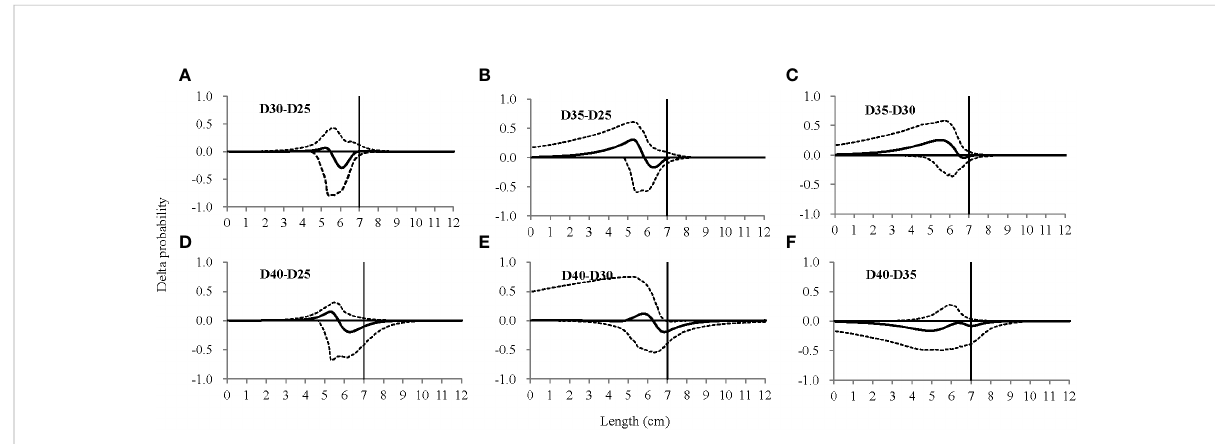
FIGURE 5 Delta selectivity from the comparison among four codends — the D25, D30, D35, and D40 codends. The solid black curves represent the delta selectivity for each comparison, and the stippled curves represent the 95% con fi dence intervals. The vertical lines represent the minimum conservation reference size (7.0 cm) of the target shrimp. (A – F) represents the D30-D25, D35-D25, D35-D30, D40-D25, D40-D30 and D40- D35 comparison, respectively.